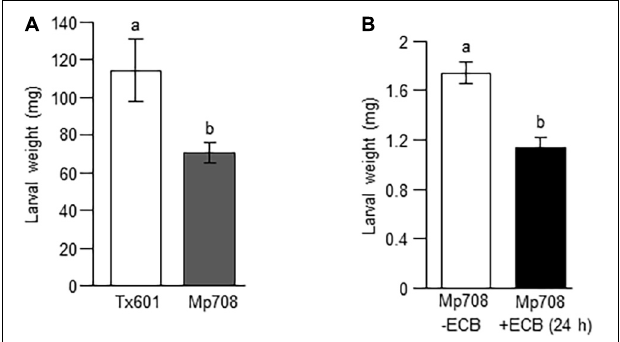
FIGURE 1 | Mp708 provides enhanced resistance to ECB and WCR. (A) Larval weight of ECB feeding on Tx601 and Mp708 plants. Two newly molted 2nd instar ECB larvae each were introduced into the whorl region of maize plants. Individual plants were caged and after 5 days ECB larvae were collected, and final weight were recorded. (B) Aboveground feeding by ECB negatively impacts the growth of belowground feeding WCR. Two newly molted 5th instar ECB (+ECB) were introduced into the whorl region of Mp708 plants. After 24 h, ECB larvae were removed from the whorl region, and two newly hatched neonates of WCR were introduced. 12 days after the introduction of WCR, the fresh weight of WCR was measured. Mp708 plants that were uninfested with ECB (–ECB) on the whorl region were used as the control. For both (A,B) , different letters above the bars indicate values that are significantly different from each other ( P < 0.05). Error bars represent ±